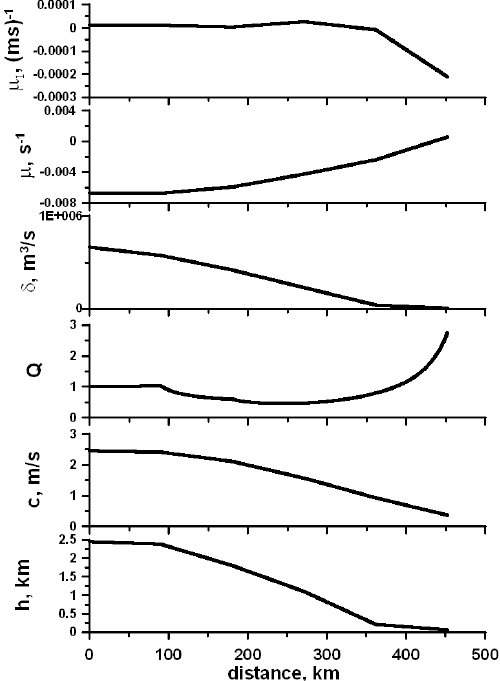
Fig. 12. Coefficients of the evKdV equation(5) along cross-section